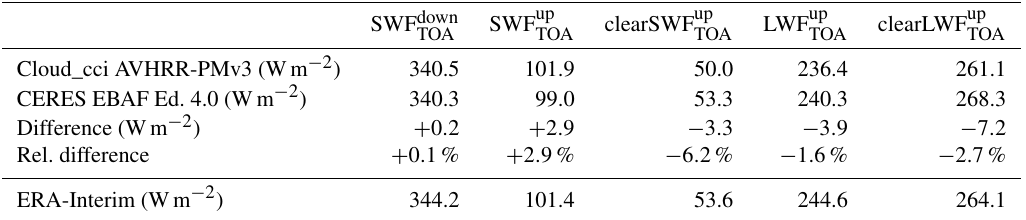
Table 10. Multi-annual (2003–2016), latitude-weighted global mean broadband fluxes at the top of atmosphere (TOA) inferred from Cloud_cci AVHRR-PMv3 dataset for all-sky and clear-sky (clear) conditions. The values are compared to equivalents inferred from Clouds and the Earth’s Radiant Energy System (CERES) Energy Balanced and Filled (EBAF) TOA Edition 4.0. All values are given in watts per square metre (Wm − 2 ). In addition, differences and relative differences (Cloud_cci-CERES) of all fluxes are reported. For comparison, ERA-Interim values are listed as